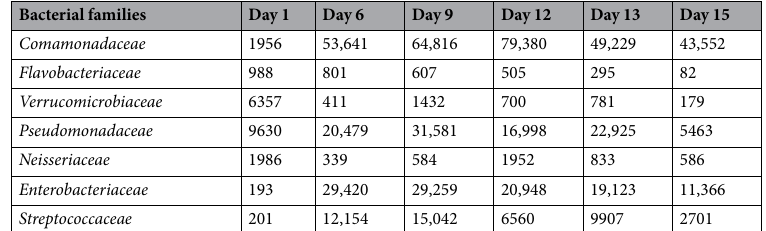
Table 1. OTU counts of bacterial families in serially passaged control